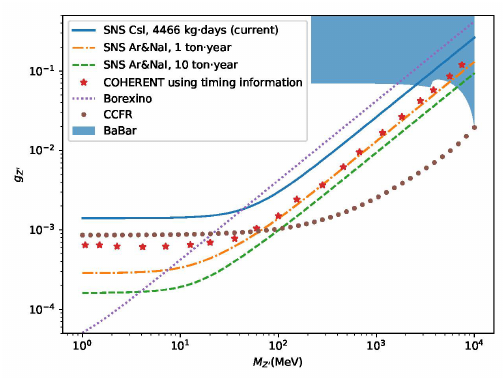
Figure 13.1: g as a function of M for L µ - L τ models. The red stars show the best Z (cid:48) Z (cid:48) fit of the COHERENT data(energy + timing). Table 13.1: The charges of fields which transform under U ( 1 ) given for the left-handed component of each Weyl spinor. The anomalies cancel by